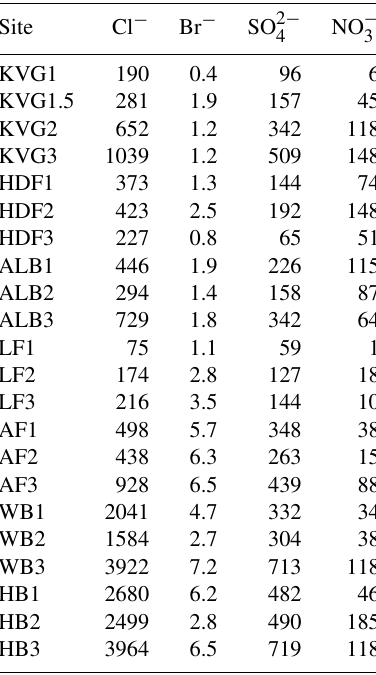
) is given as a percentage and bromide enrichment dep